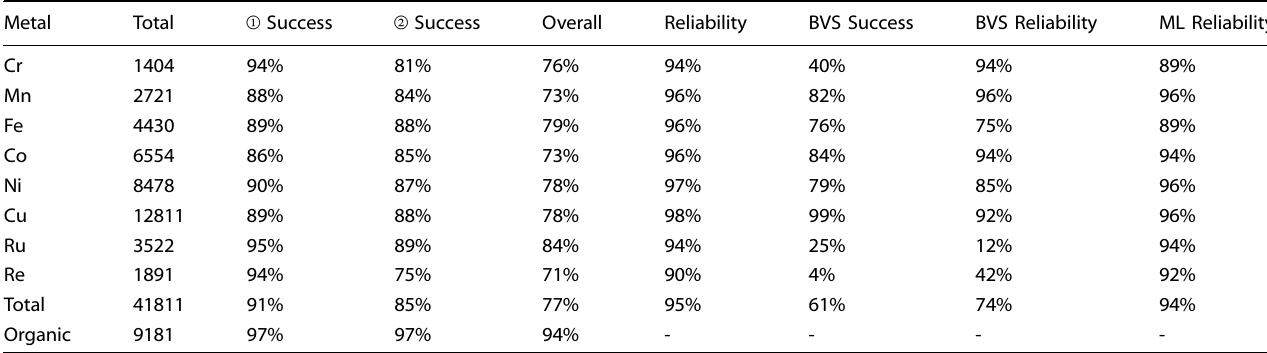
Table 1. Results on the cell2mol characterization of unit cells with mono-metallic TM complexes included in the test set (See Supplementary Note 5 for unit cells with bi- and poly-metallic complexes).